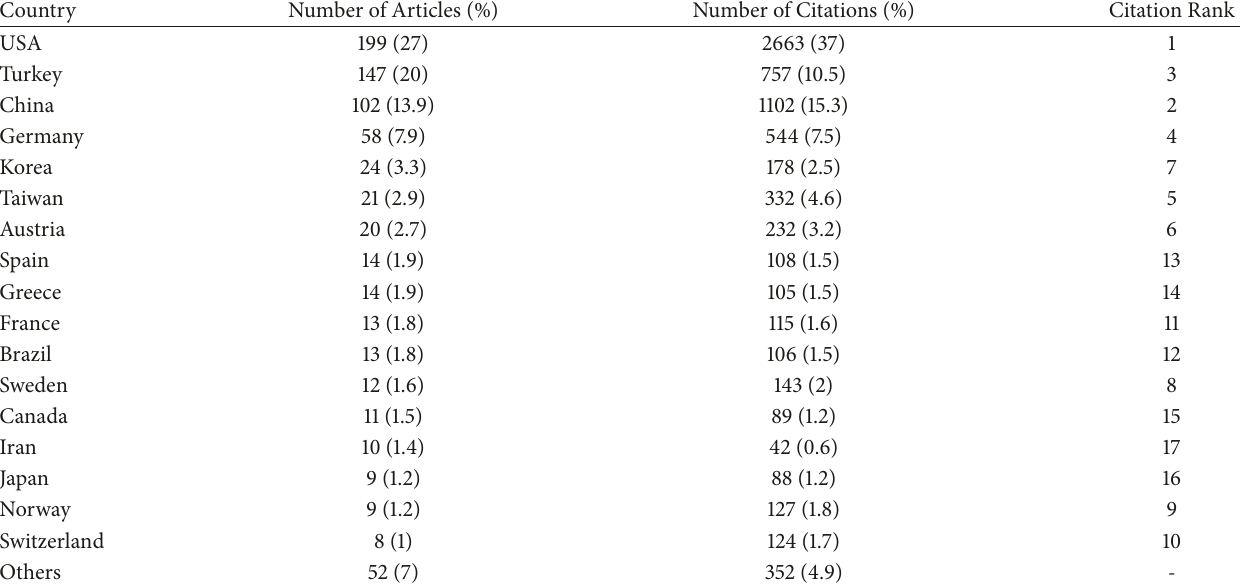
Table 2: Distribution of the articles and their citation status according to